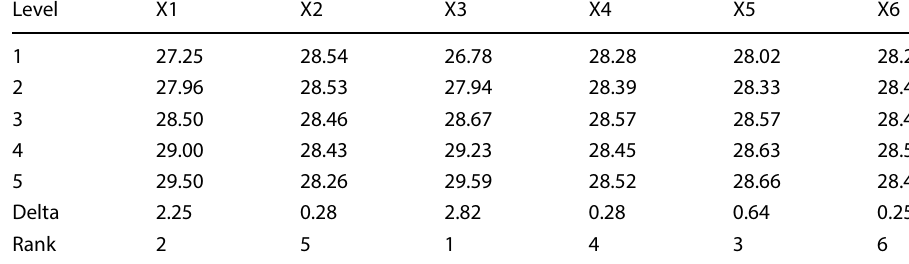
Table 6 Response table for signal to noise ratios (AF), larger is